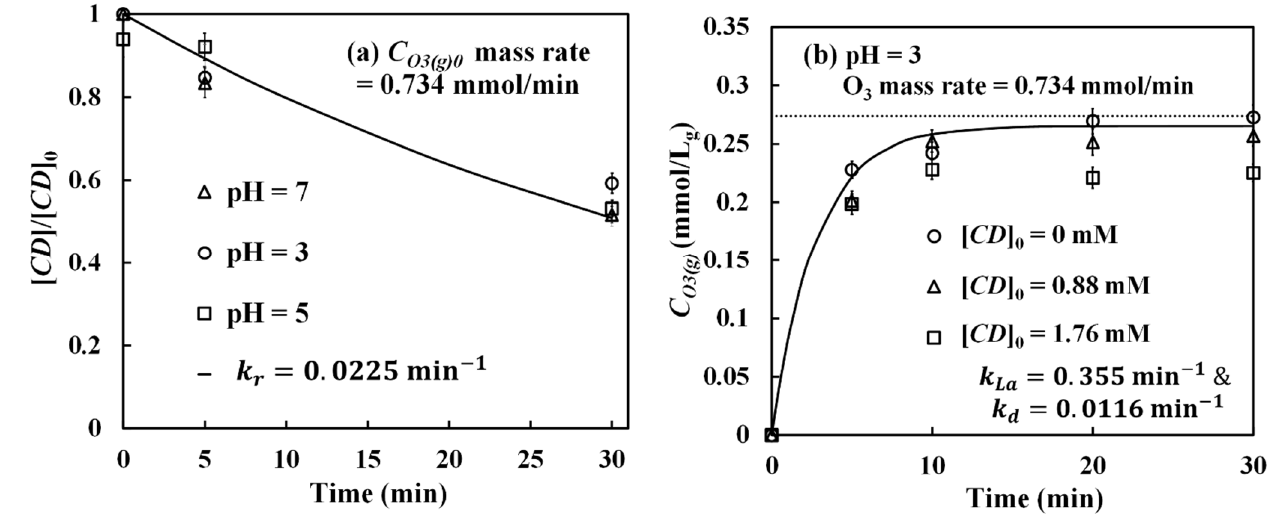
Figure 2. ( a ) β -CD degradation in the gas-absorption reactor during the preparation of the O 3 - β CD inclusion complex at pH 3, 5, and 7; ( b ) Gaseous ( C O 3 ( g ) ) ozone breakthrough curves from the gas-absorption reactor under various β -CD concentrations at pH 3.